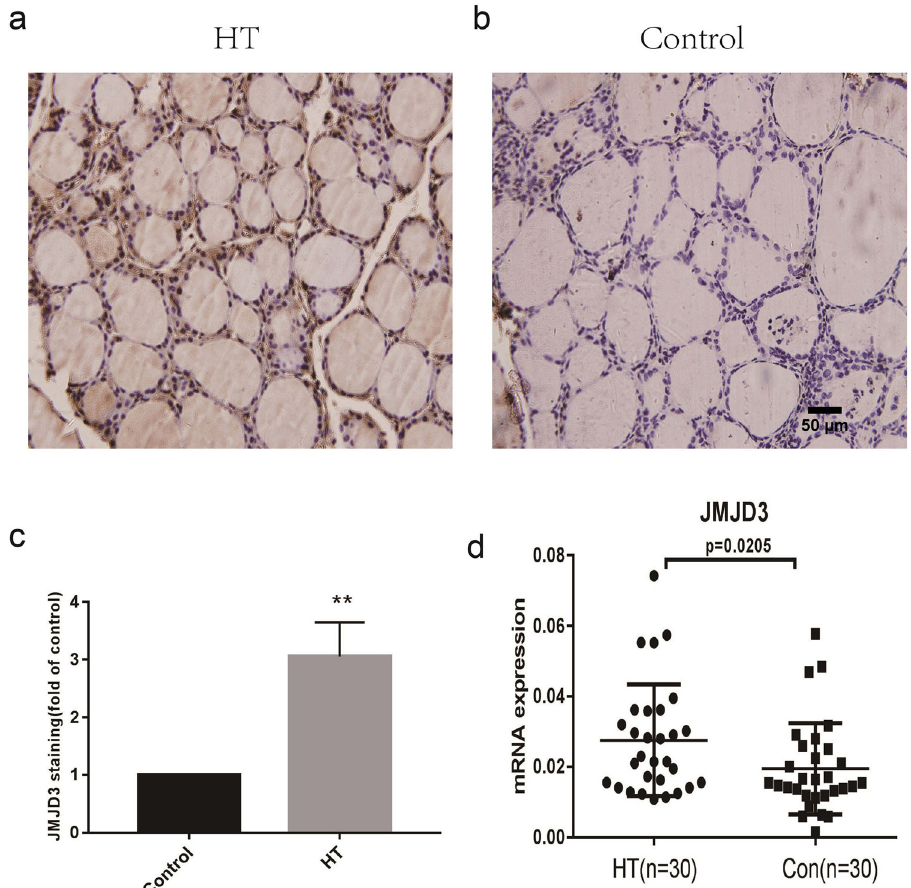
Figure 1: Overexpression of JMJD3 in the thyroid tissue of HT patients. Con: control. ( a ) Immunohistochemical to detect JMJD3 in thyroid gland from HT patients ( n = 6 ) . ( b ) Immunohistochemical to detect JMJD3 in age - matched control patients ( n = 6 ) . ( c ) Histogram to show protein level of JMJD3. ( d ) JMJD3 mRNA expression in HT and control groups ( n = 60 ) . ** P < 0.01 vs